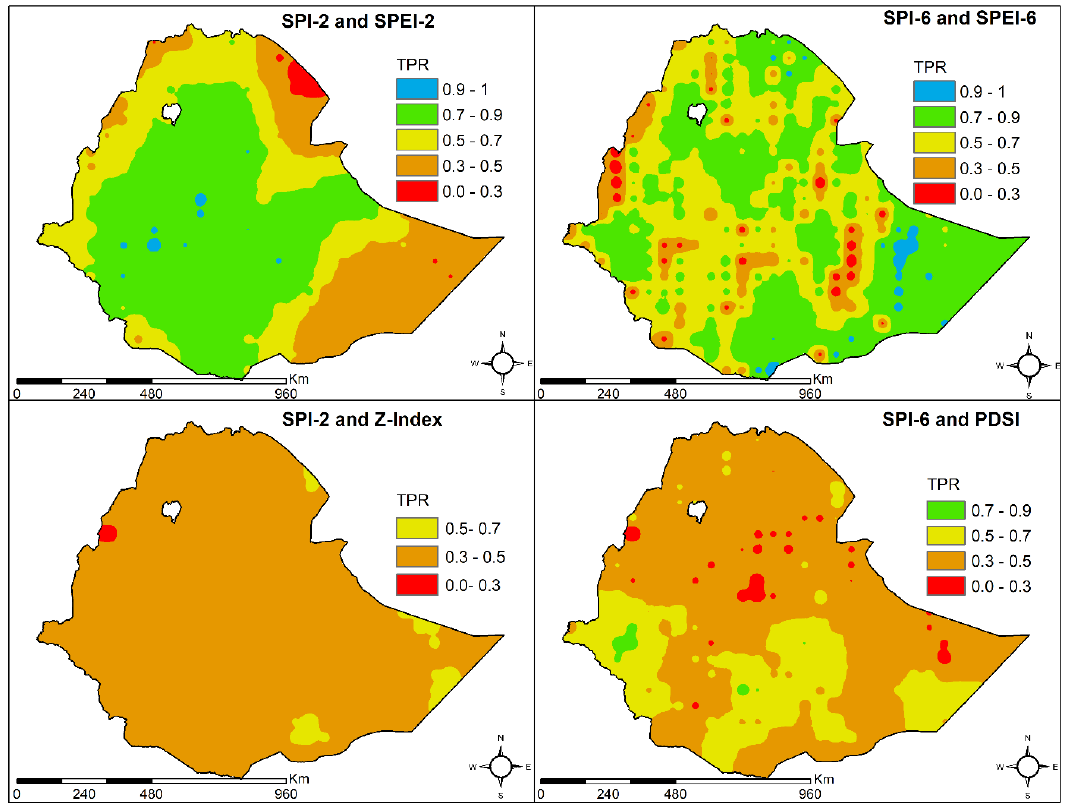
Figure 6. True Positive Rate (TPR) for various agricultural-meteorological drought combinations in Ethiopia.